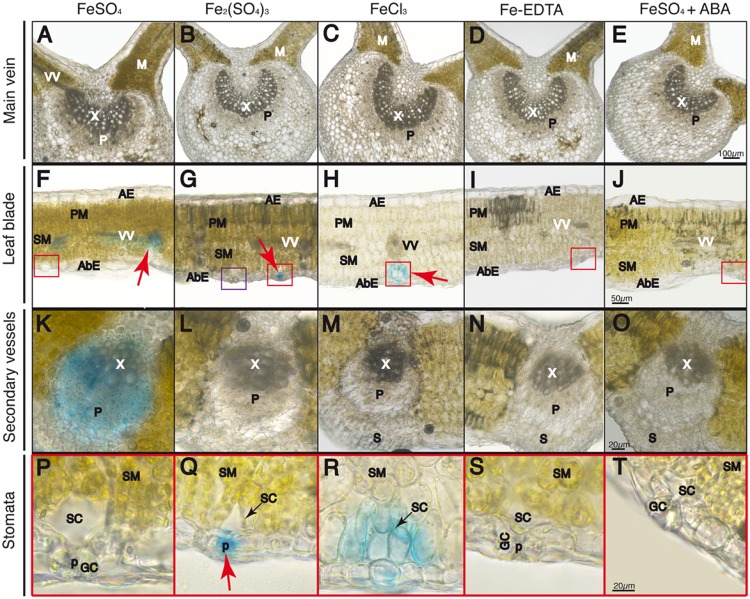
Localization of labile Fe pools using Perls blue staining in transversal leaf sections taken 60 min after Fe foliar fertilization: main vein (A–E), leaf blades (F–J), close-up of minor veins in F–J (K–O) and close-up of stomatal areas in red squares in F–J(P–T). Leaves were treated with FeSO4
(A,F,K,P), Fe2(SO4)3
(B,G,L,Q), FeCl3
(C,H,M,R), Fe(III)-EDTA (D,I,N,S), and FeSO4 in ABA-treated plants (E,J,O,T). Phloem and xylem tissues (P and X, respectively) and mesophyll tissue (M) are marked in images (A–E) and (K–O); abaxial and adaxial epidermis (AbE and AE), parenchima and spongy mesophyll tissue (PM and SM), and stomatal guard cells (GC), cavities (SC), and pores (p) and vascular vessels (VV) are marked in images (F–J) and (P–T). The scale bars correspond to 100, 50, and 20 μm in (A–E), (F–J), and (K–T), respectively.